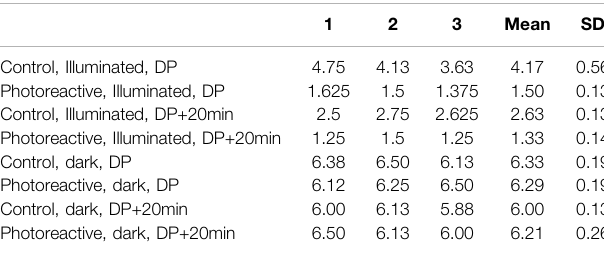
FIGURE8| Evaluation ofthe virucidal effect ofthephotoreactive surface at 4 ° C. DP: Desiccation point. TABLE 2 | The TCID50 values in three replicates, surfaces were incubated at 4 °